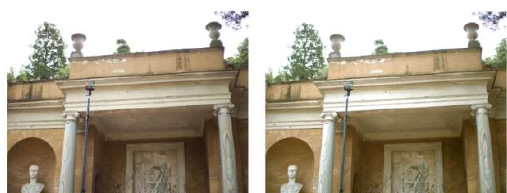
Figure 12. Two raster images from photo “A10”: left, uncalibrated TIFF file; right, calibrated TIFF